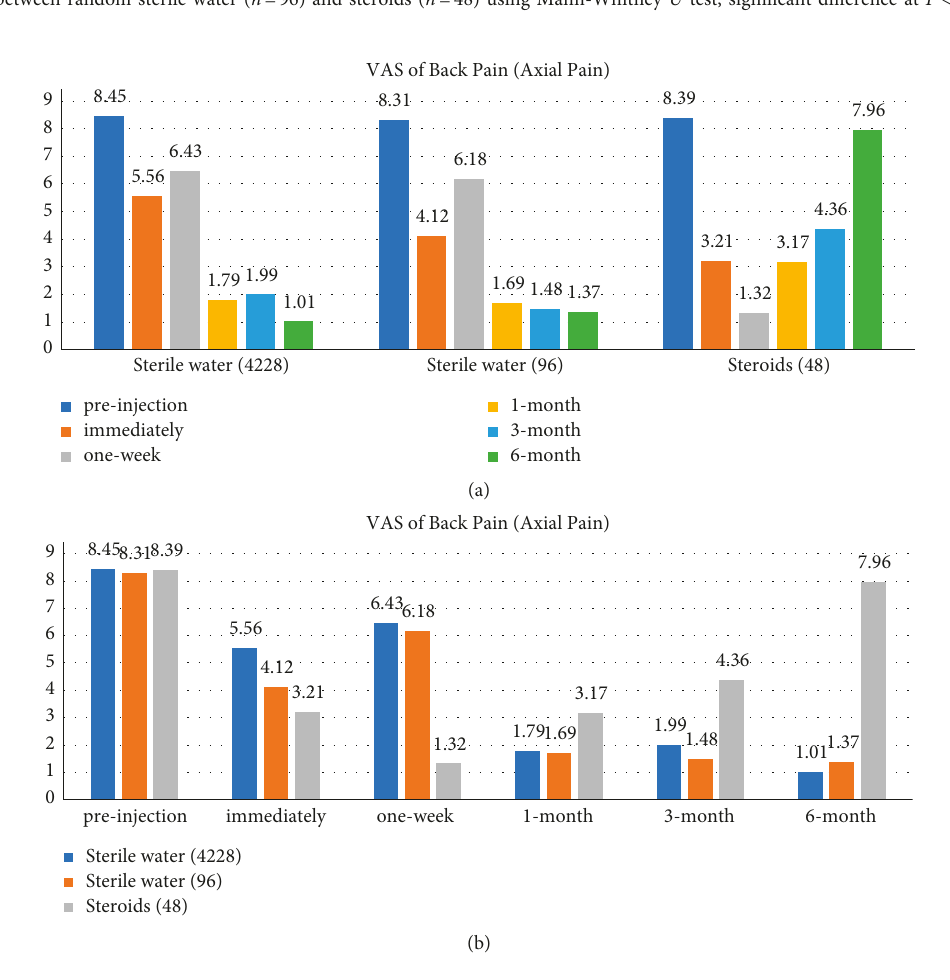
Figure 2: The comparison within group (a) and between groups (b) of VAS for back pain (axial pain) at 6 time points as preinjection (T0), immediately (T1), one week (T2), 1 month (T3), 3 months (T4), and 6 months (T5) after